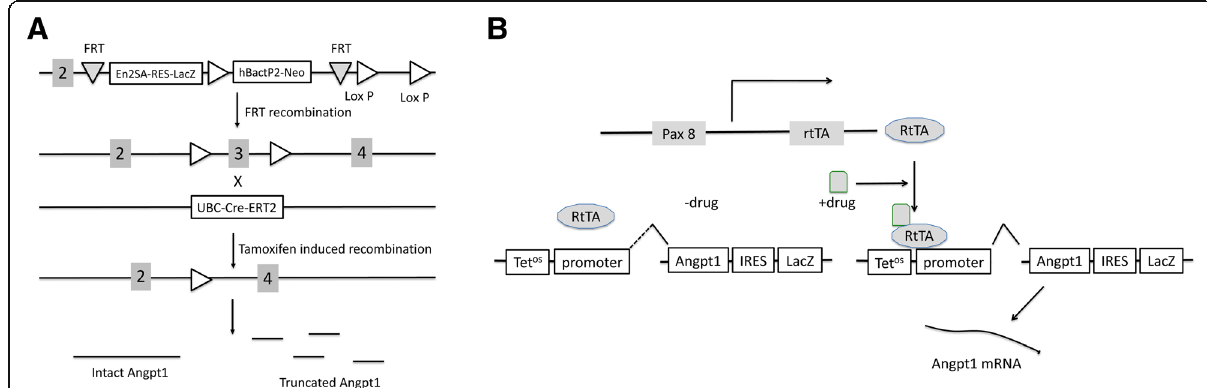
Fig. 1 a Design of inducible whole body Angpt1 knockout mice. Angpt1 exon 3 floxed Angpt1 flox/flox mice were mated with UBC/CreErt2(Tg) mice to generate the UBC-CreErt2(Tg)/Angpt1 flox/flox mice. After the induction with tamoxifen, exon 3 of Angpt1 was excised. The truncated Angpt1 mRNA was expressed and degraded or abnormal Angpt1 protein was translated. b Design of renal tubule specific inducible Angpt1 over- expression mice. Pax8-rtTA(Tg) mice were mated with pTre-hAngpt1(Tg) mice to generate the Pax8-rtTA(Tg)/pTre-hAngpt1(Tg) mice. After the induction with doxycycline, the renal tubule began to generate human Angpt1